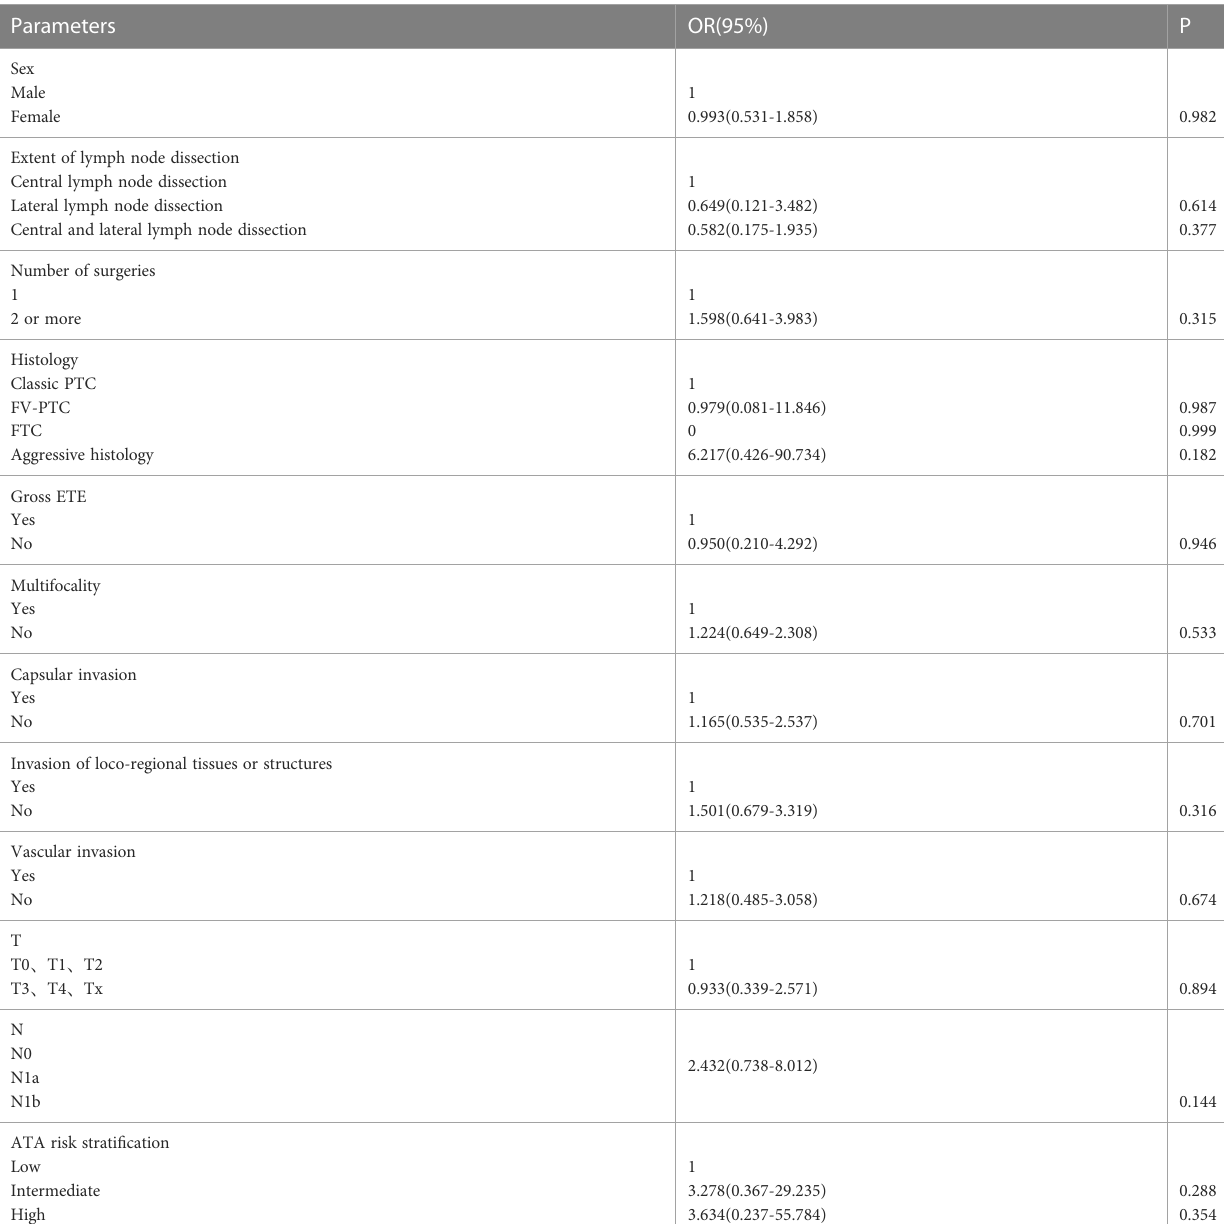
TABLE 3 Multivariate analysis of predictors of persistent/recurrent